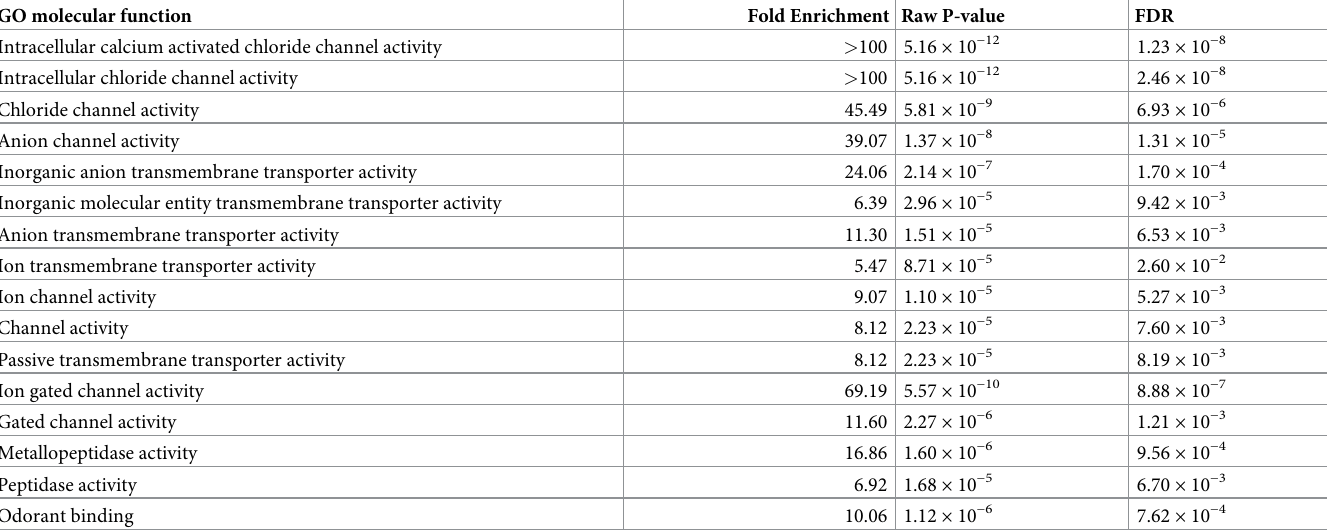
Table 3. Gene ontology enrichment analysis of regions with extreme Λ values in the New York City rat